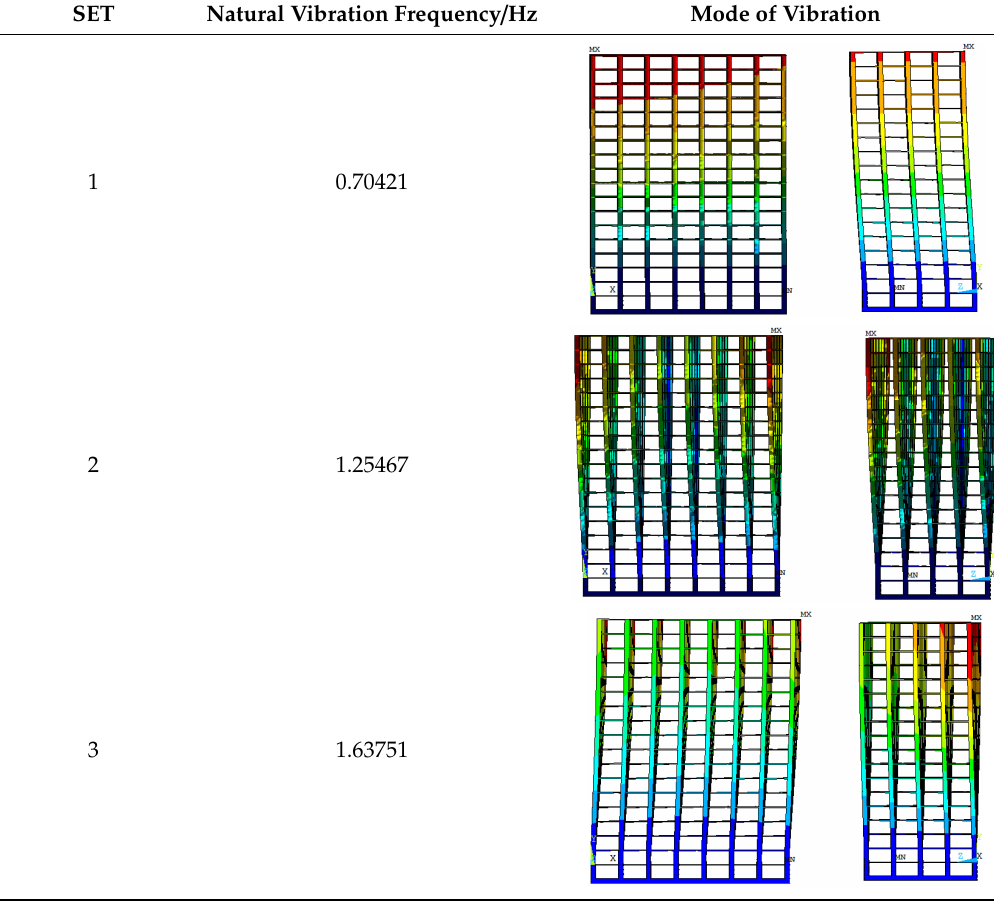
Table 10. The first 3th order natural vibration frequencies and mode of vibration.